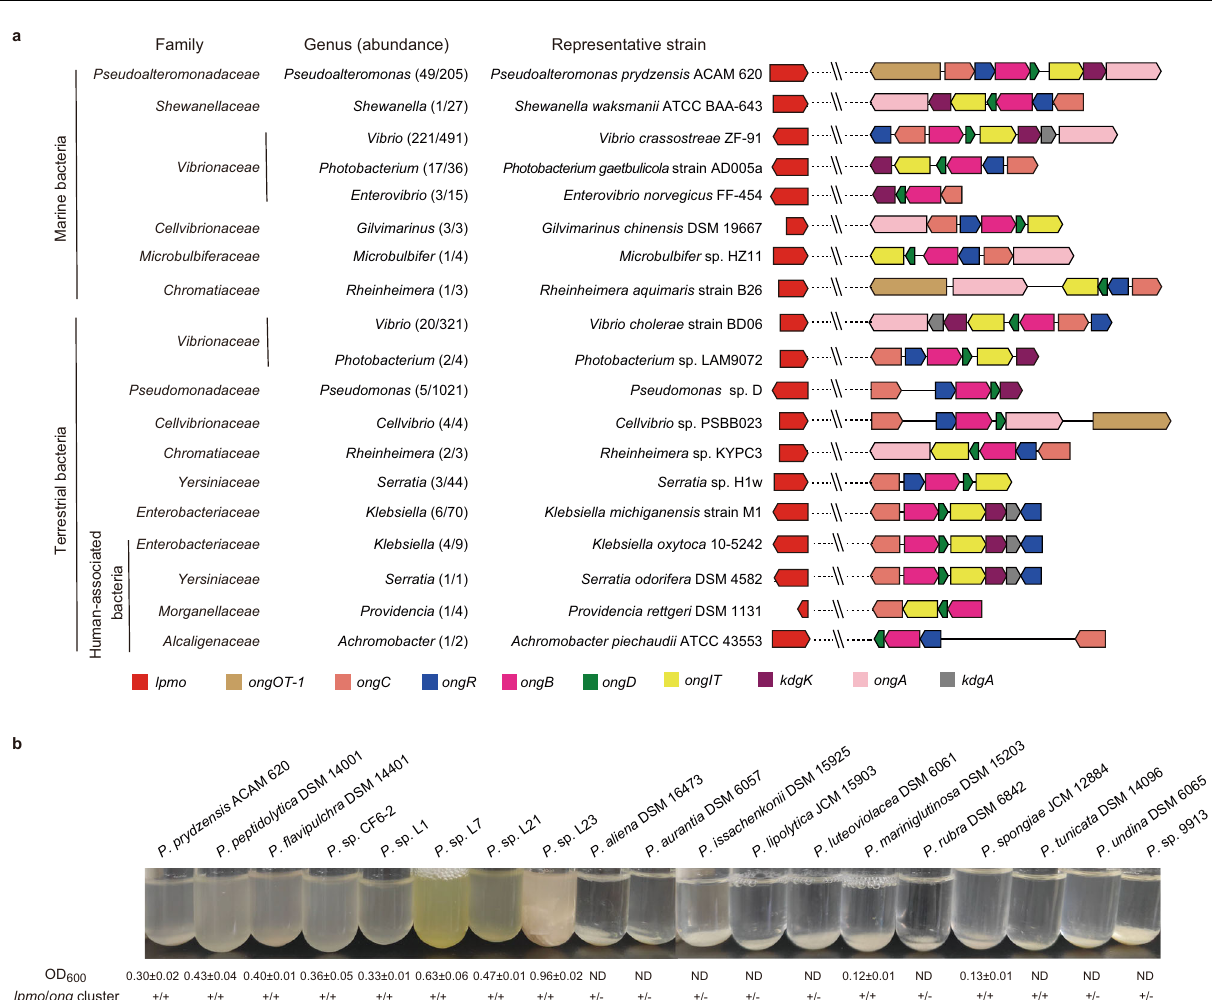
Fig. 6 | Distribution and ecological function of the oxidative chitin utilization pathway in bacteria. a Distribution of the oxidative chitin utilization pathway in marine and terrestrial bacterial isolates. Except for terrestrial bacterium Achro- mobacter piechaudii ATCC 43553 belonging to Betaproteobacteria, all other bac- terial strains with the complete oxidative chitin utilization pathway are from Gammaproteobacteria. For some representative strains containing more than one lpmo genes, only one lpmo gene wasshown. b Comparison ofthe chitin-degrading abilities and related chitin-degrading genes of Pseudoalteromonas strains. Strains werecultivatedintheminimalmediumsupplementedwith0.2%(w/v)shrimpshell